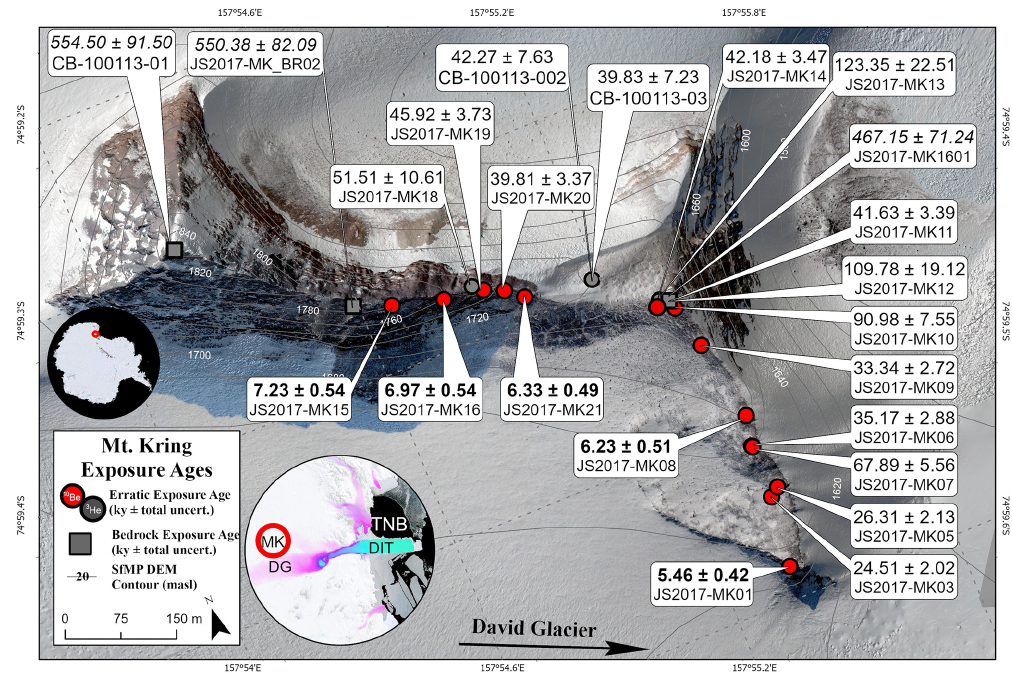
Figure 3. Orthomosaic map of Mt Kring with all exposure ages, 10 Be (red) and 3 He (grey), and total errors. Erratics and bedrock ages plotted as circles and squares, respectively. Bold ages indicate Holocene age erratics, and italicised ages indicate bedrock exposure. Large inset displays ice surface velocity of Rignot et al. (2011), and small inset displays LIMA data of Bindschadler et al. (2008). DG: David Glacier; DIT: Drygalski Ice Tongue; TNB: Terra Nova Bay; MK: Mt Kring.